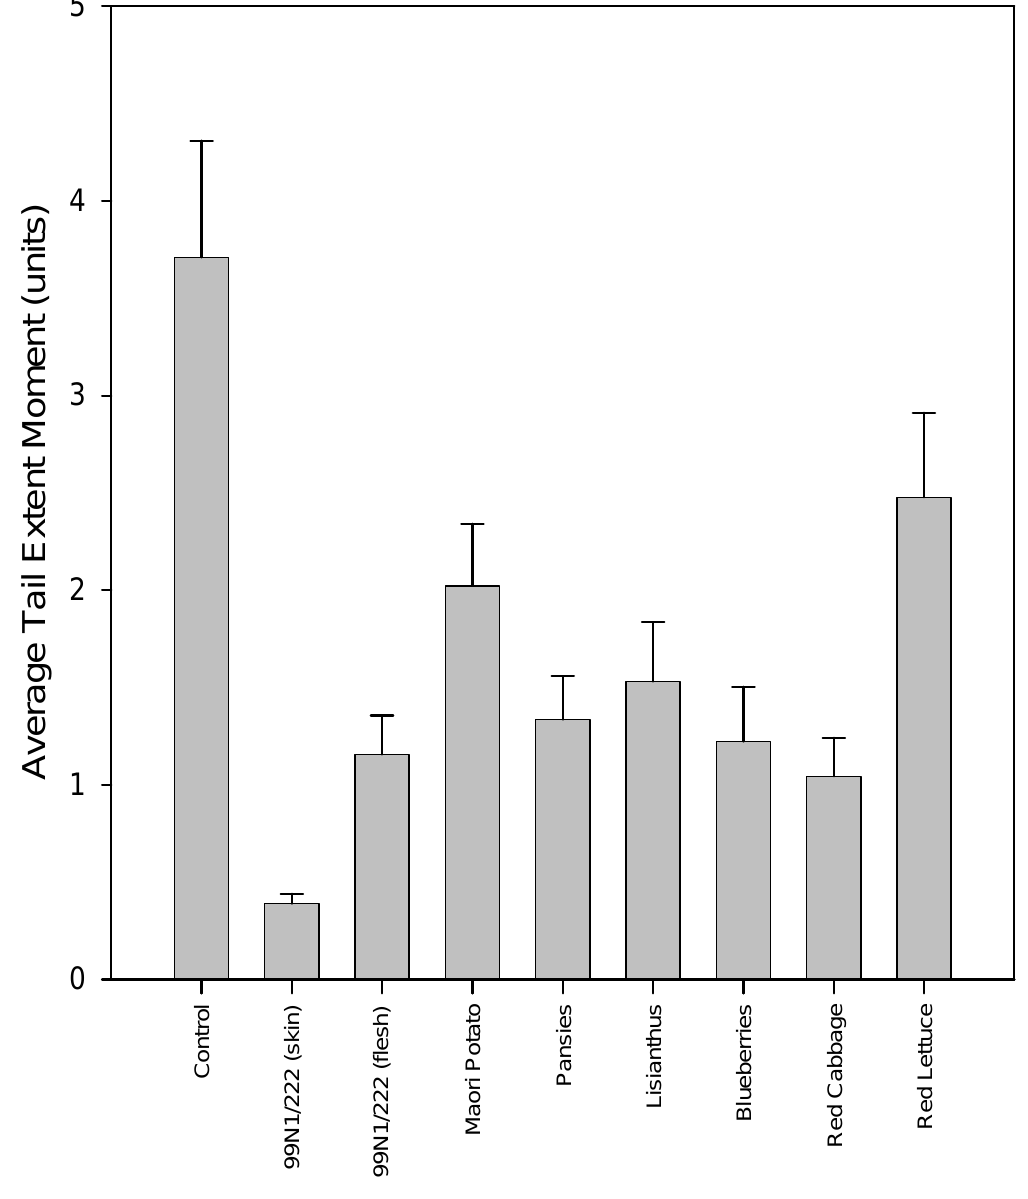
Figure 7 . Bar graph showing the average tail extent moments and standard errors from 100 comets incubated in different anthocyanic plant extracts in the untreated